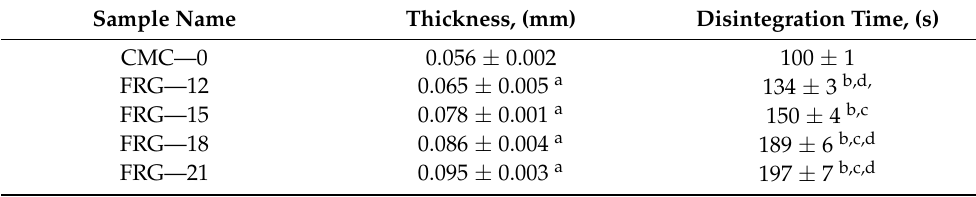
Table 3. Physical properties of sublingual films based on CMC with G. biloba ethanol extract